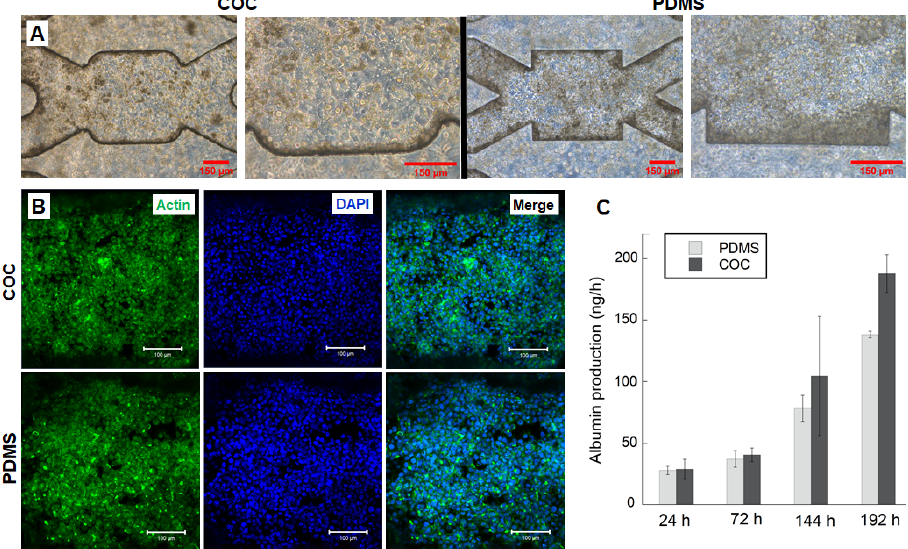
Figure 8. Characterization of HepG2/C3a cells after 9 days of culture in COC and PDMS biochips: ( A ) cell morphology (scale bar 150, ( B ) Phalloidin and DAPI stainings: DAPI (nuclei, blue) and phal- loidin (F-actin, green); scale bar 100 µm, ( C ) Albumin production throughout the 8 days of perfu- sion.